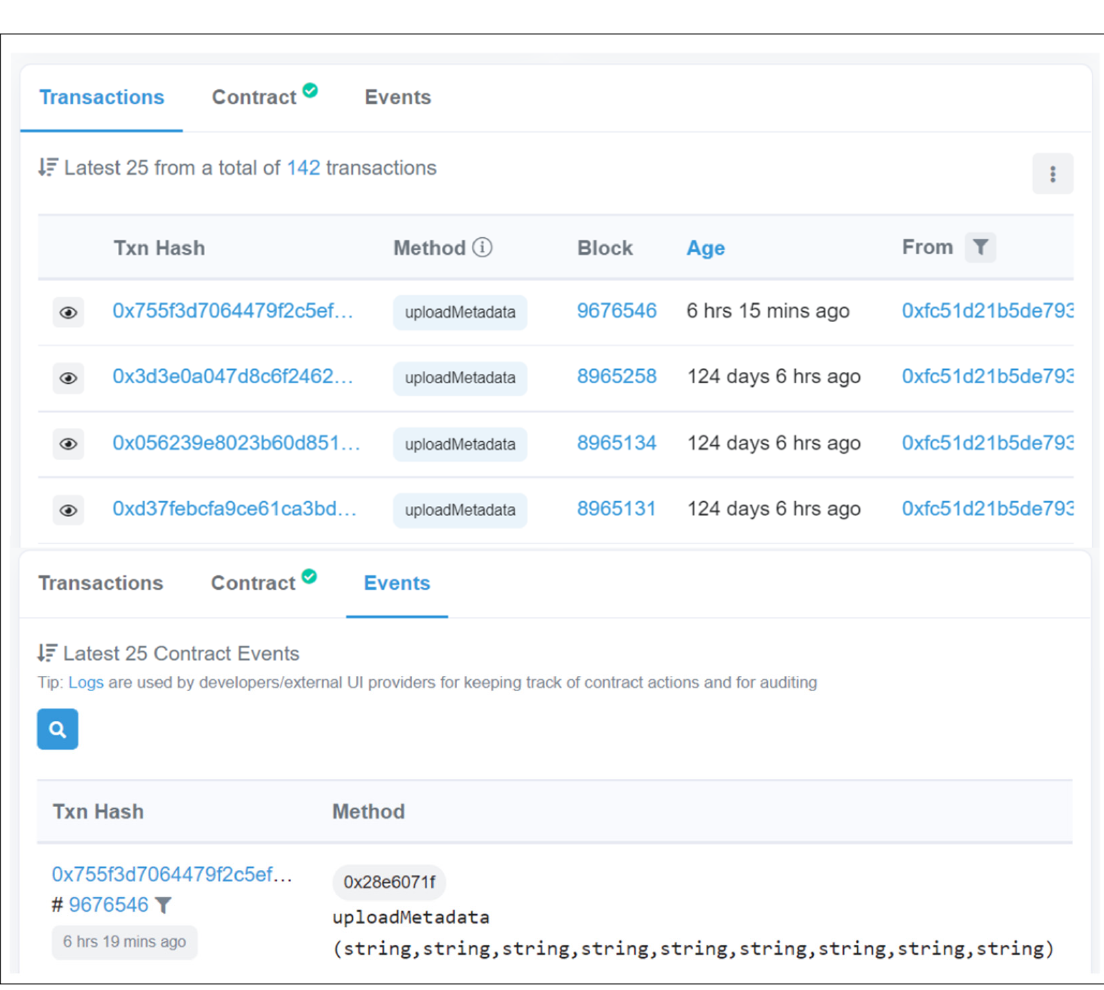
Figure 13. Blockchain Event and Transactions.